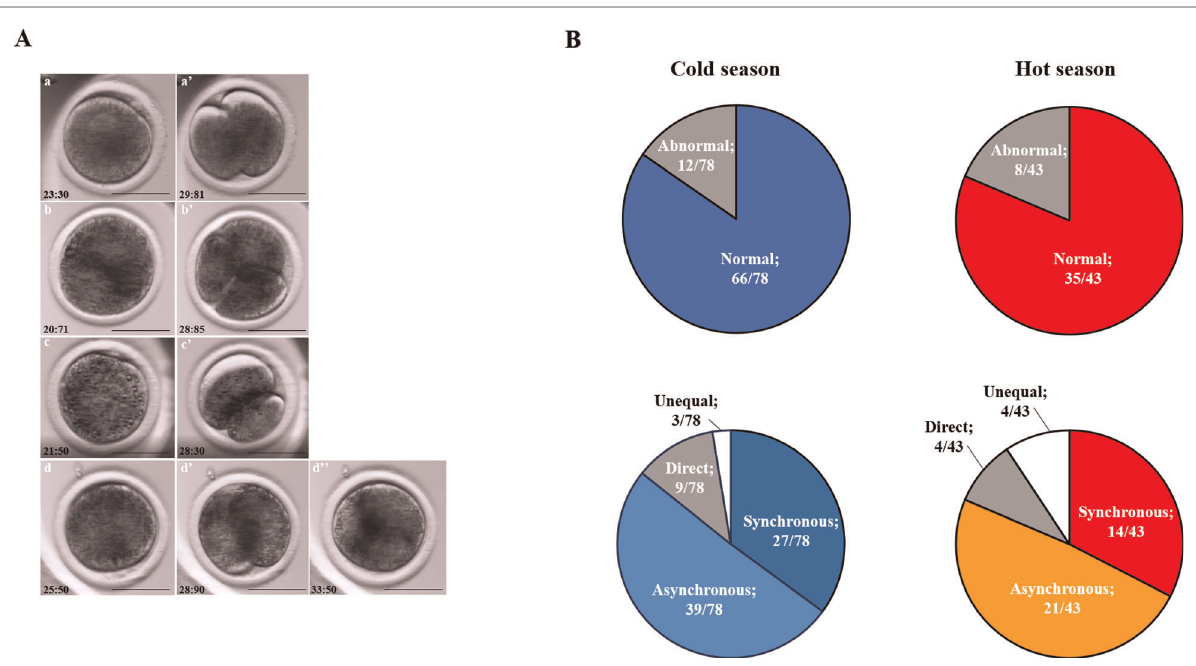
FIGURE 3 Cleavage pattern of the fi rst division. ( A ) Representative images of the fi rst cleavage pattern of normally and abnormally cleaved embryos. Presented are (a, a ’ ) putative zygotes after fertilization that exhibited a Normal cleavage pattern and that are characterized by two equally sized blastomeres; putative zygotes that directly cleave, from 1 cell into 3 blastomeres (b, b ’ ); putative zygotes that exhibited an unequal cleavage are characterized by two blastomeres of unequal size (c, c ’ ); putative zygotes that exhibited a reverse-cleavage and are characterized by two blastomeres fused into one cell (d, d ’ , d ’‘ ). Scale bar=50 µm. ( B ) Pie charts demonstrating the distribution of the developed blastocysts into Normal and abnormal cleavages within each season (Upper panel). Further distribution of the developed blastocyst from normally (synchronous and asynchronous) and abnormally (direct, unequal) cleaved embryos within each season (Bottom panel). Presented are the total number of blastocysts in each group/